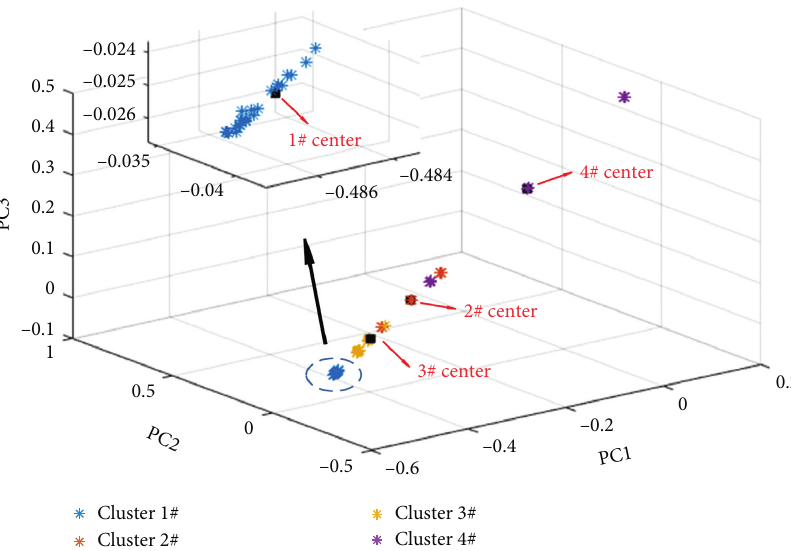
Figure 15: Effect of K -means cluster